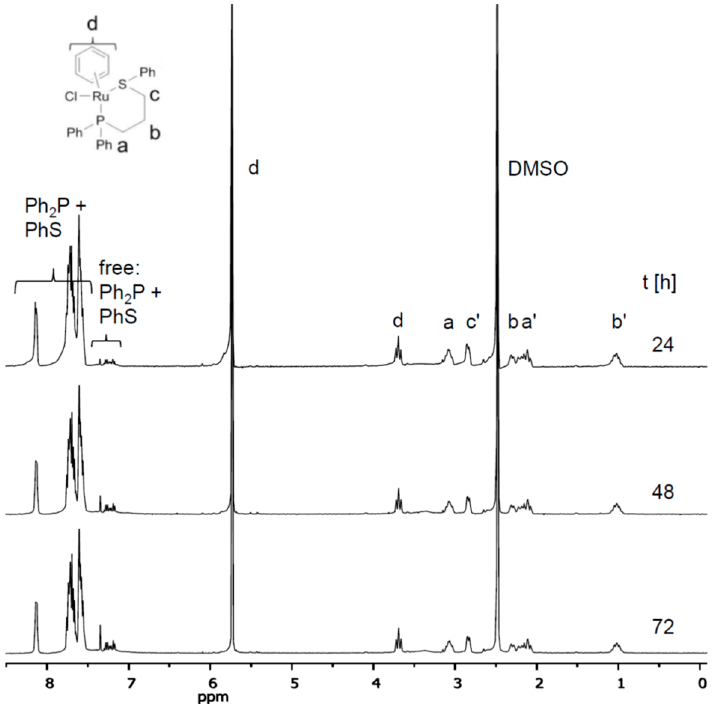
Figure 4. Decomposition of the 4a cation, as an example, in DMSO- d 6 observed by time dependent 1 H NMR spectroscopy over 72 h.